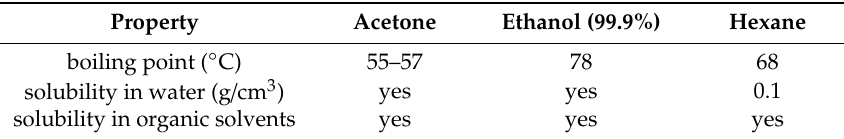
Table 1. Physical properties of solvents employed in